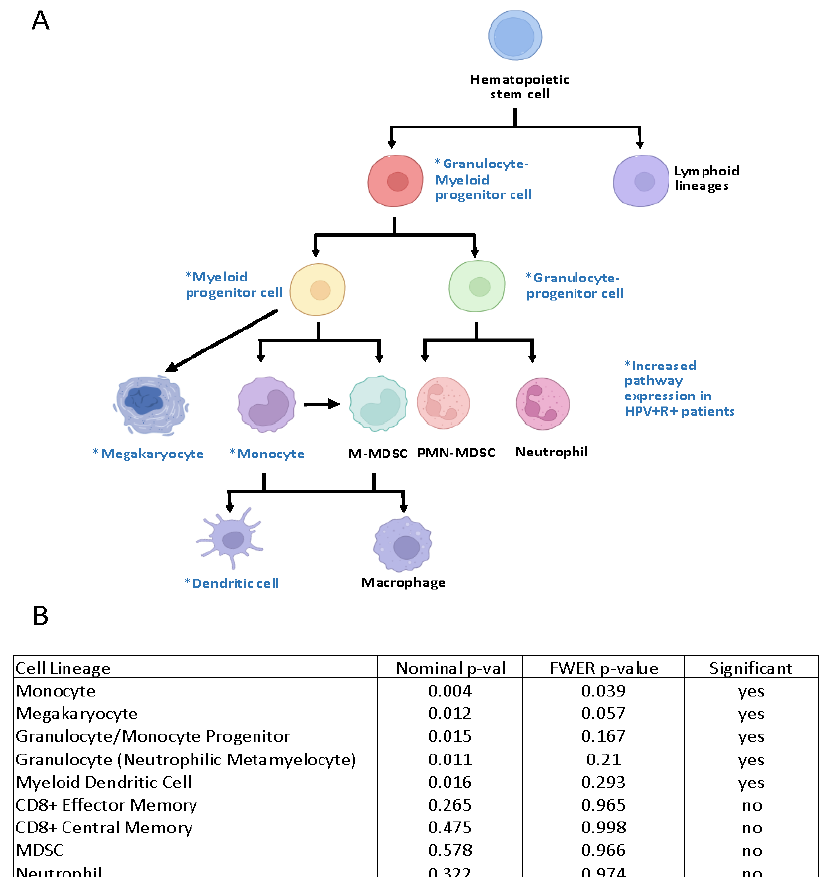
Figure 2. Summary of enriched granulocyte-myeloid cell lineages in HPV+R+ patients vs. HPV+R-. ( A ). GSEA analysis revealed enrichment of granulocyte-myeloid pathways in HPV+R+ patients, including myeloid and granulocytic progenitor cells, which give rise to suppressive monocytes/macrophages and MDSCs. ( B ). List of cell lineages and significance levels for pathways evaluated. *=increased expression of pathway in HPV+R+ patients.